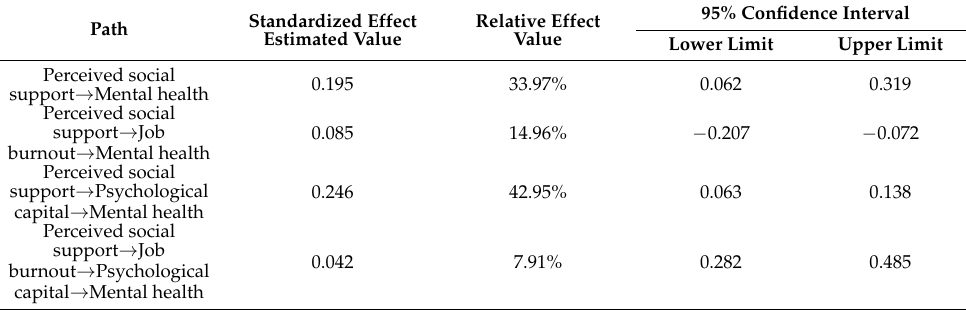
Table 16. Bootstrap analysis of path effect significance